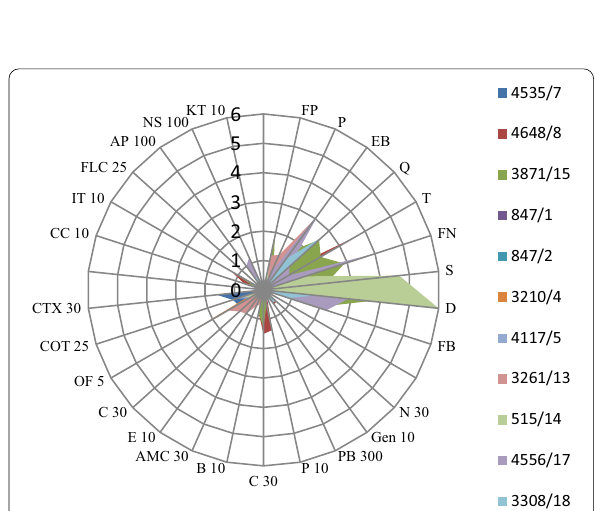
Fig. 6 Overall pesticide, antibiotic and antifungal tolerance capability of our isolated